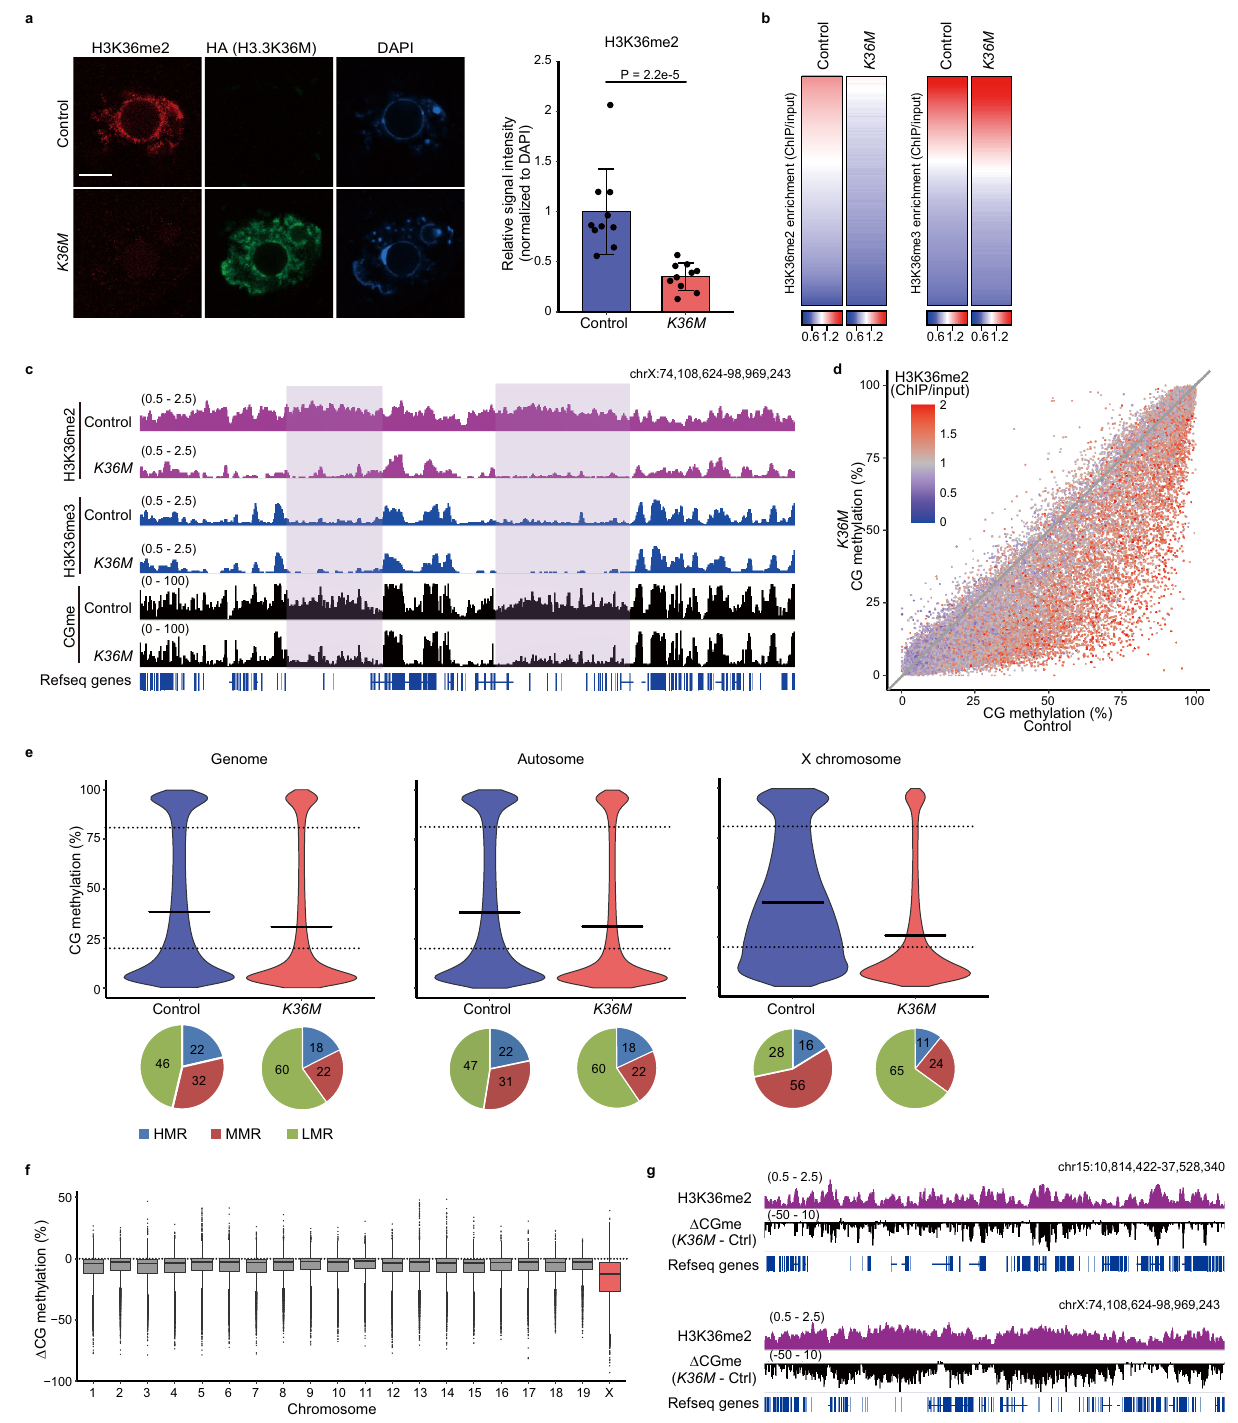
maternal and zygotic H3.3K36M lead to similar phenotypes, it is cur- rently unclear whether the loss of H3K36me2 in oocytes alone leads